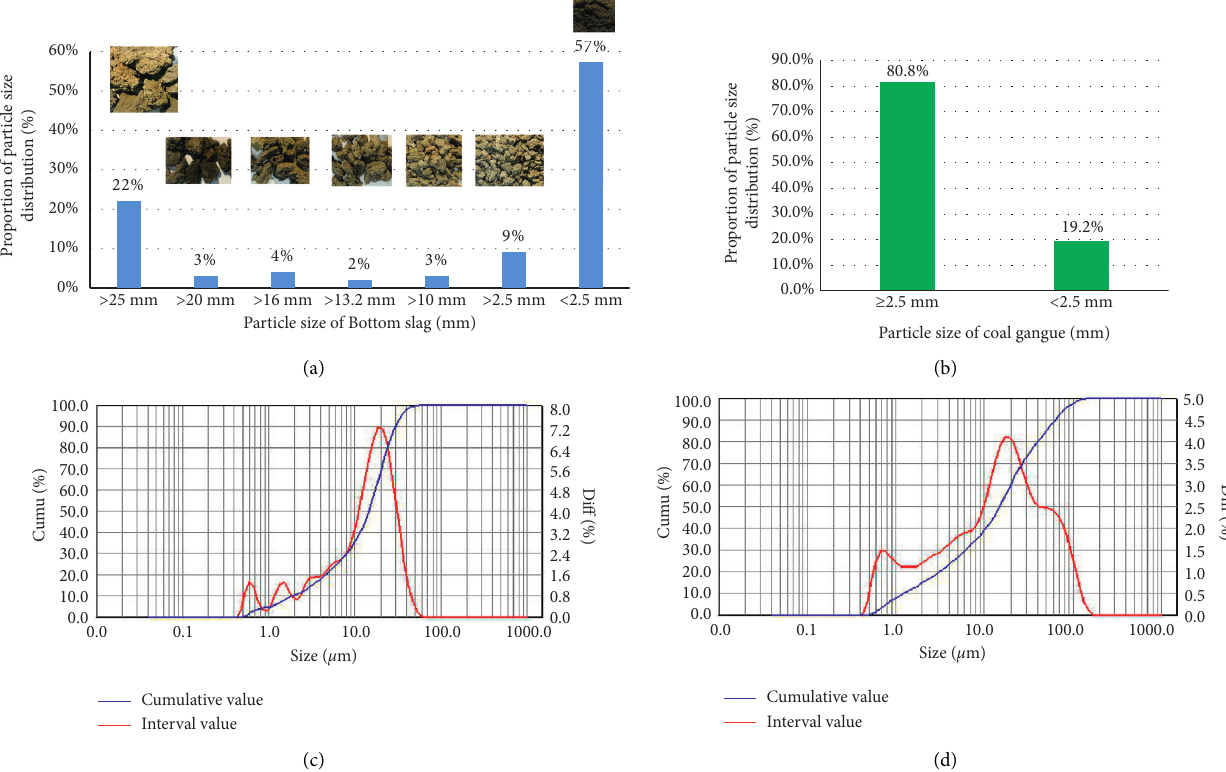
Figure 4: Statistical analysis of particle size distribution of furnace bottom slag, broken coal gangue, and fine particle raw materials before proportioning experiment. (a) Furnace bottom slag. (b) Coal gangue. (c) Fly ash. (d)